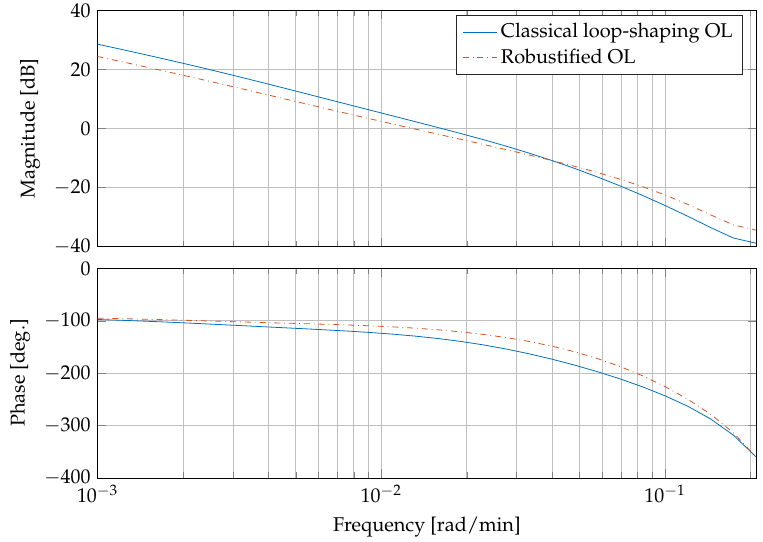
Figure 6. Frequency response of the compensated open loop (OL) L ( z ) with classical controller and compensated loop L ∞ ( z ) with the robust